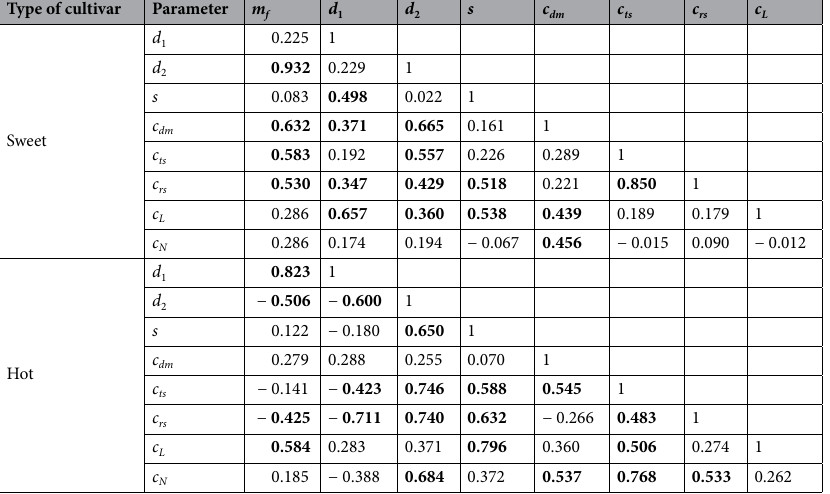
Table 5. Pearson’s coefficients of correlation between the analyzed parameters of Capsicum annuum fruit. m